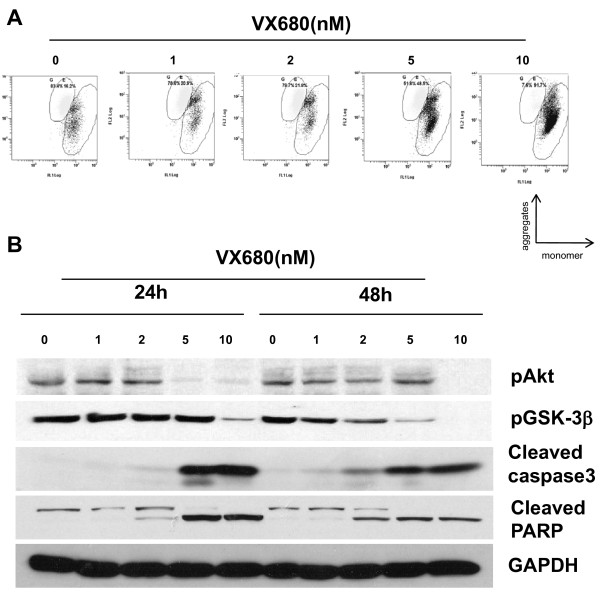
VX-680 induces mitochondrial depolarization and cellular caspase activation in NB4-R2 cells. (A) VX-680 treated NB4-R2 cells were stained with JC-1 probe and measured by flow cytometry. X- and Y-axes were indicative of monomer and aggregates, respectively. Data shown is a representative of three independent experiments. (B) NB4-R2 cells were collected, lysed and subjected to Western blot analysis with cleaved caspase-3, cleaved-PARP, pAkt-1 (Ser473), pGSK-3β (Ser9) specific antibodies. GAPDH was used as a loading control. Data shown is a representative of three independent experiments.